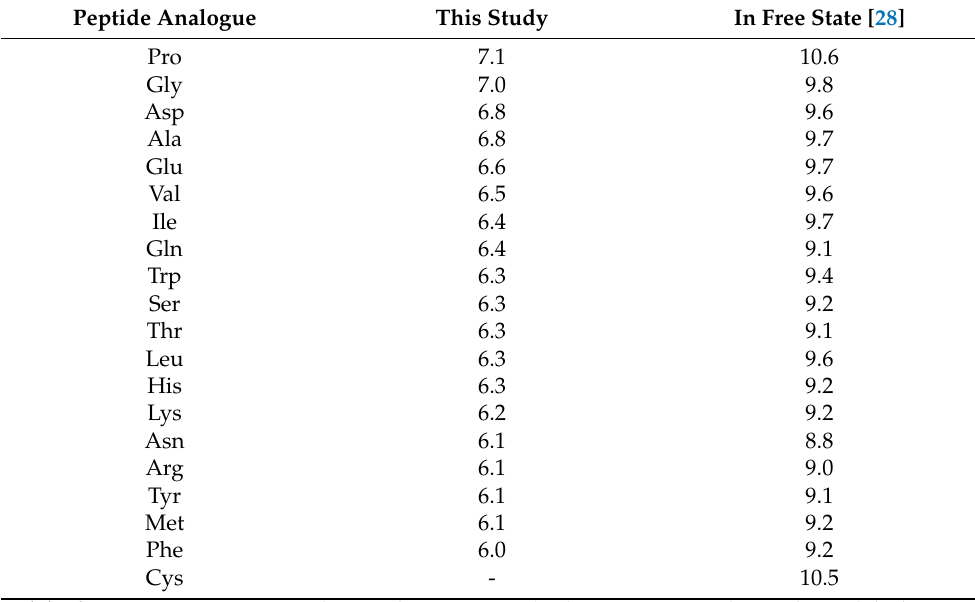
Table 5. pKa values for various α -amino group of peptide analogues, 19 N -terminus amino acids [26]. Peptide Analogue This Study In Free State [28] Pro Gly